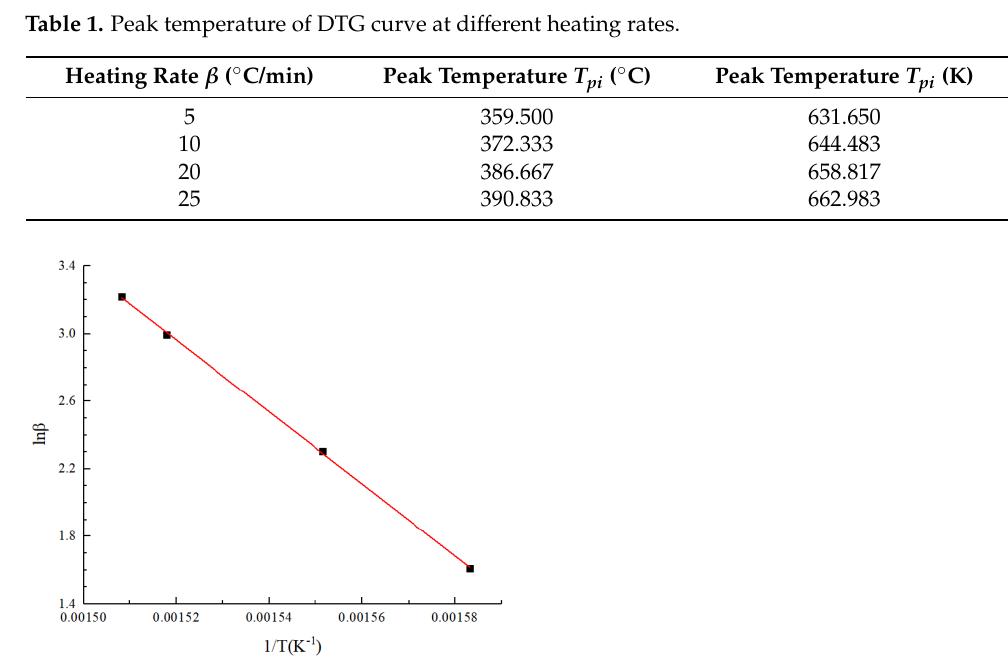
Figure 3. Linear fitting results at maximum thermal decomposition rate based on the Flynn–Wall– Ozawa method.